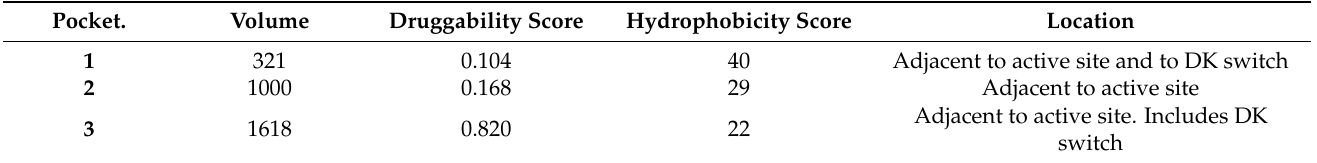
Table 1. Data from the Fpocket prediction for the selected putative binding